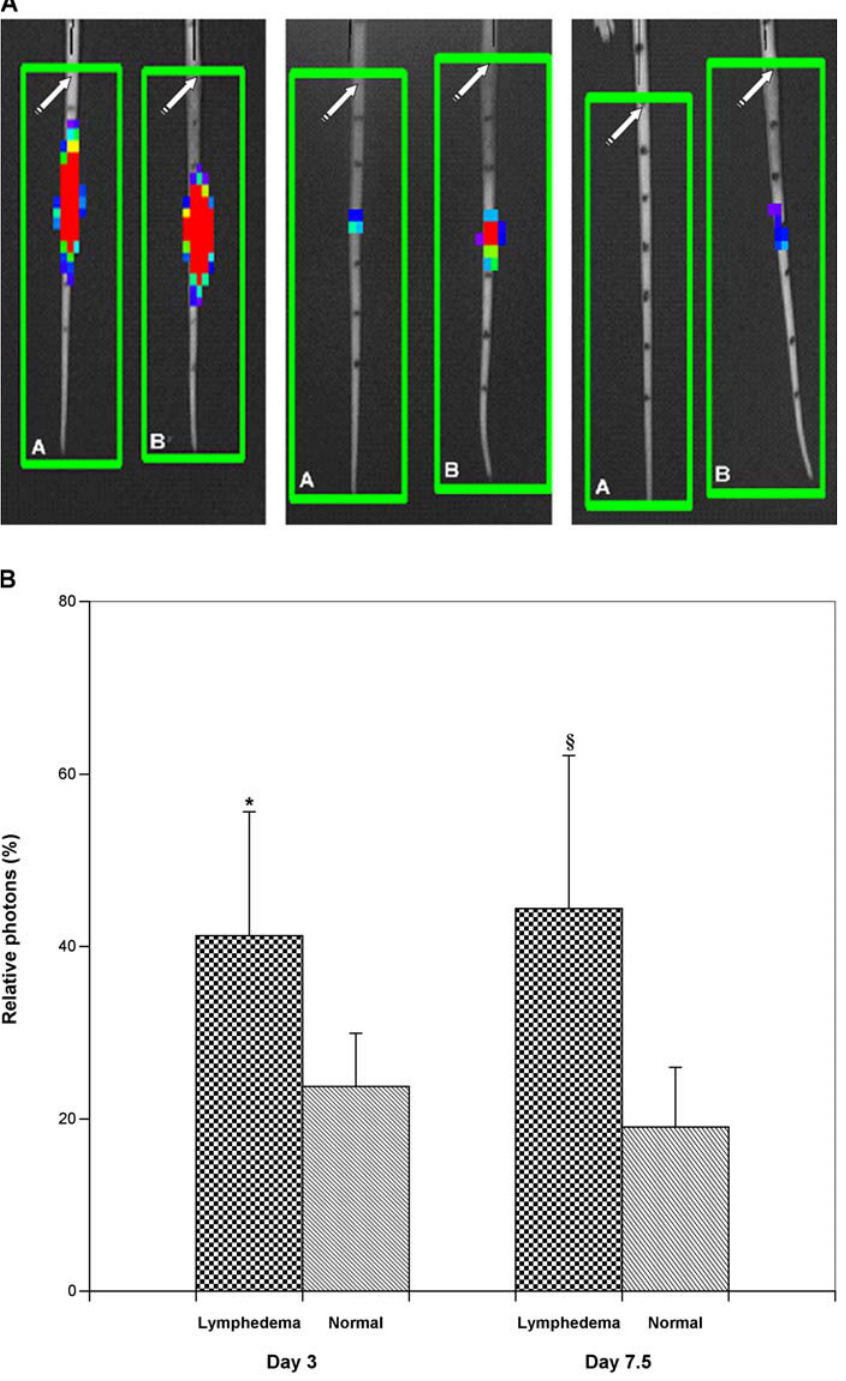
Figure 4. Dynamic Imaging of Immune Traffic in Experimental Lymphedema (A) In vivo bioluminescence imaging of immune traffic. Bioluminescence imaging was performed at defined time points following the introduction of luc þ cells. This figure contains a representative series of imaging experiments for paired normal control (A) and lymphedema (B) mice. Photon densities range from red (high) to blue (low). In general, clearance of bioluminescent immunocytes from the lymphedematous tails was delayed, but remained unimpaired in the surgical sham controls. The left panel shows a perceptible increase in photon densities in lymphedema on day 3 post-injection (post- operative day 10). Within several days, the disparity in cellular clearance is even more evident (middle panel); as late as day 17 post-injection, there is still visible bioluminescence in the lymphedematous tail, while all activity has cleared from the normal tail (right panel). The original surgical site is depicted by the white arrows. The black marks on the tail denote 8-mm vertical distances; splenocyte injection was performed 24 mm below the surgical site. (B) Quantitative assessment of in vivo bioluminescence imaging of immune traffic. Relative photon density, expressed as a percent of the observed value on day 1, was significantly greater in lymphedema than in normal controls, both at day 3 and at day 7 post-injection (*, p , 0.05; §, p , 0.02). DOI: 10.1371/journal.pmed.0030254.g004